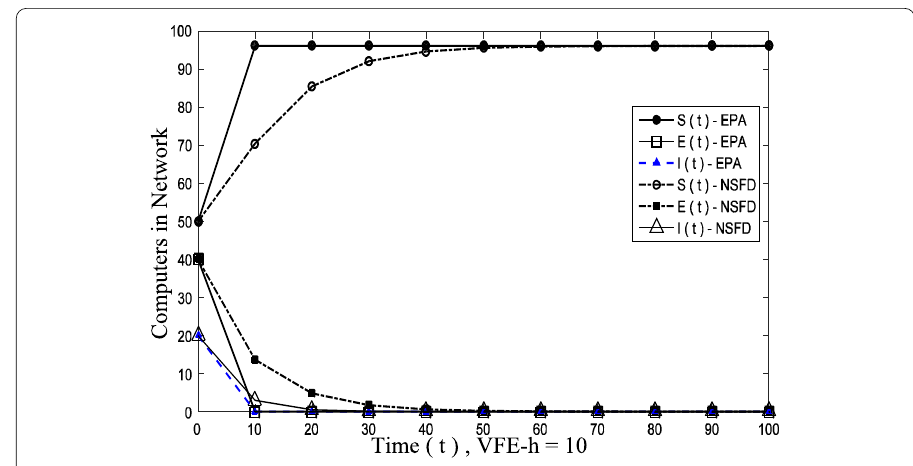
Figure 9 Convergence curves of EPA and NSFD to VFE point at h = 10